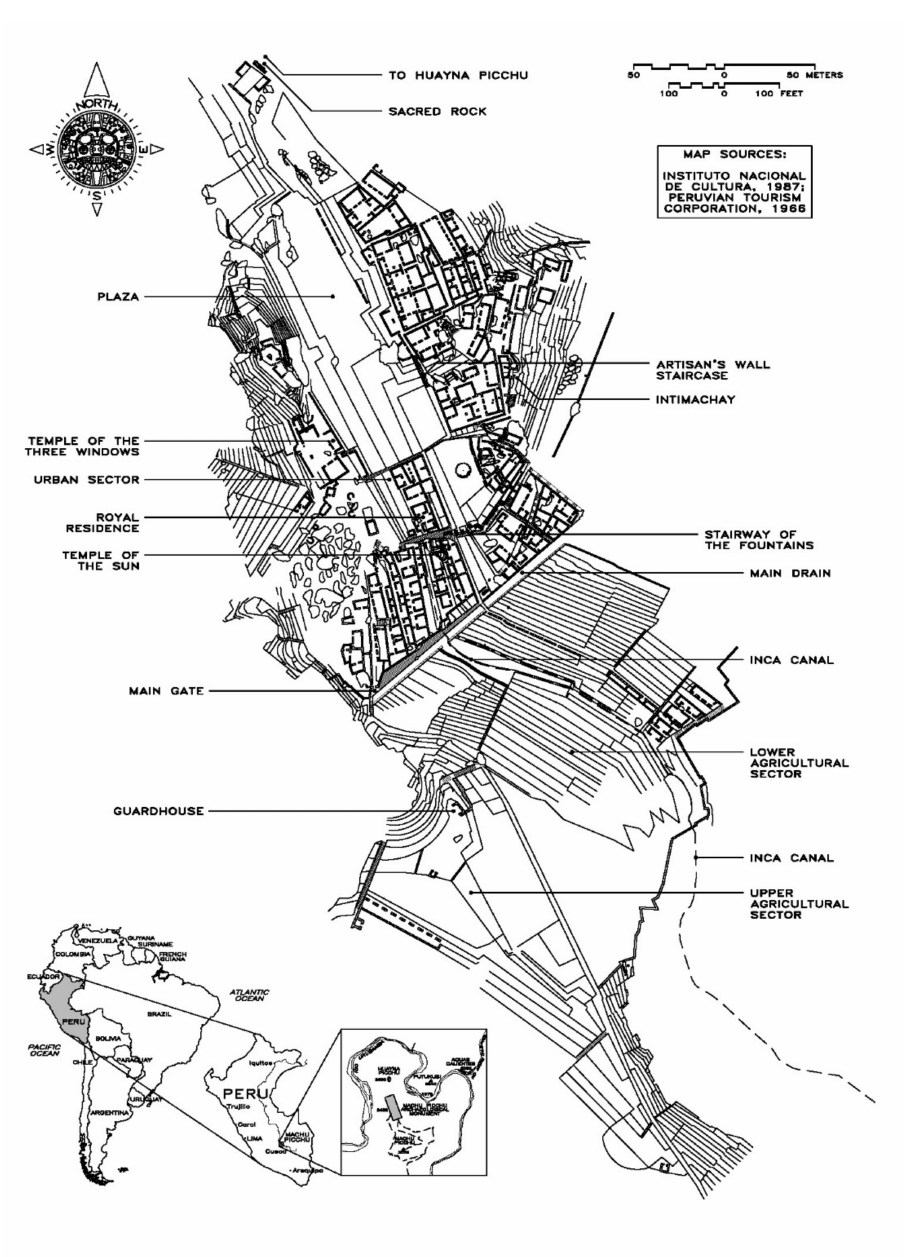
Figure 3. Site map showing layout and key features of Machu Picchu